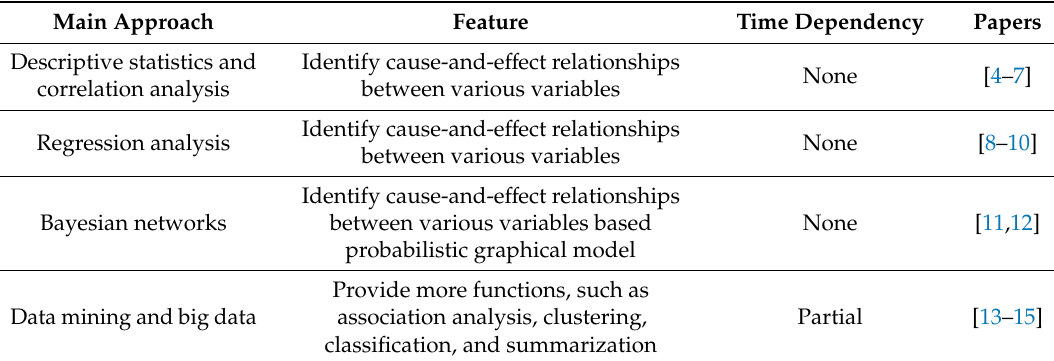
Table 1. Summary of relevant PSC analysis